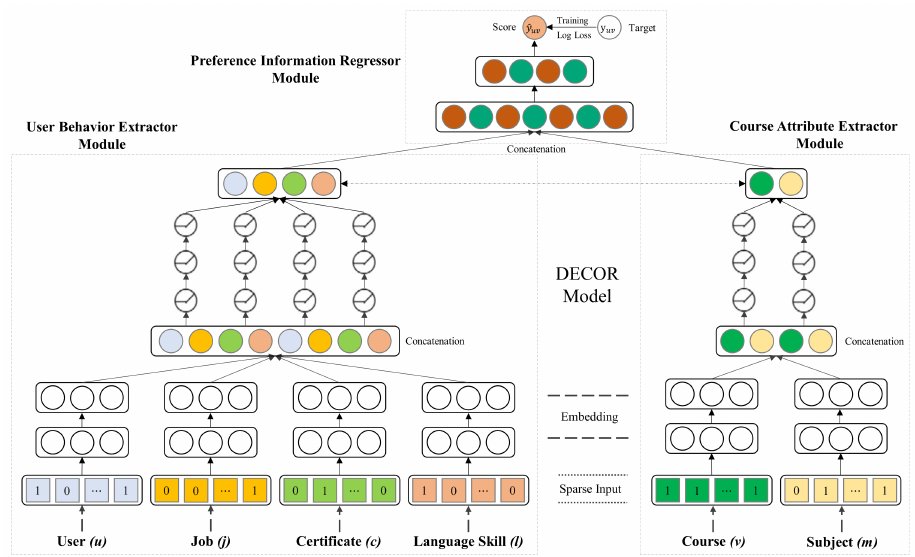
Figure 1. Overview of the proposed DECOR model